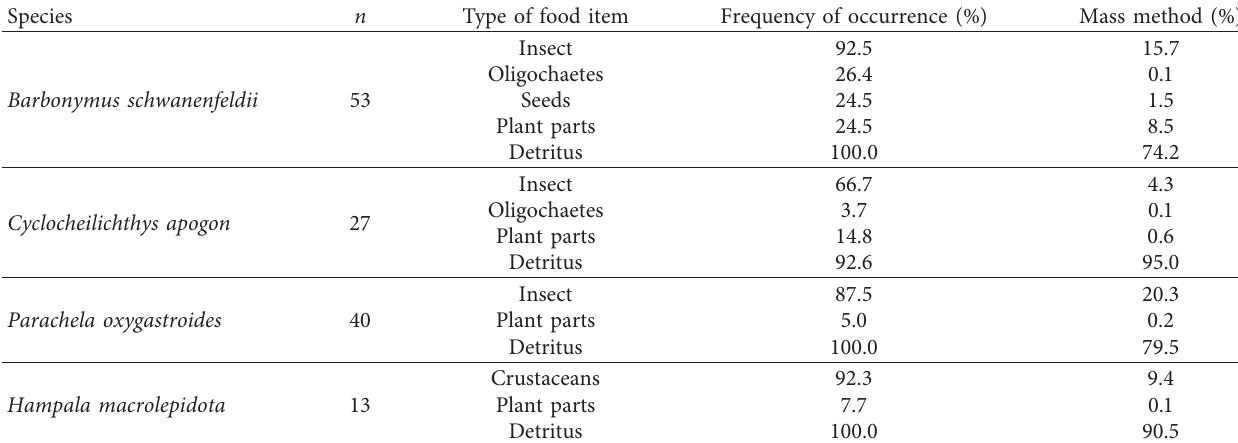
n , number of individuals; K , condition factor; SD, standard deviation. Table 7: The stomach content analysis of four selected species by using the frequency occurrence of food and mass method. Species n Type of food item Mass method